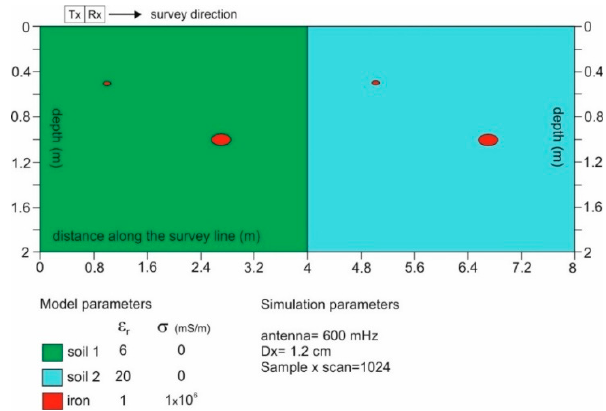
Figure 2. The synthetic model adopted to simulate the appearance of diffraction hyperbolas in GPR profiles. Subsurface EM characteristics and simulation parameters are indicated. Surface locations of the objects are labelled A, B, C, and D. Tx: transmitter; Rx: receiver.